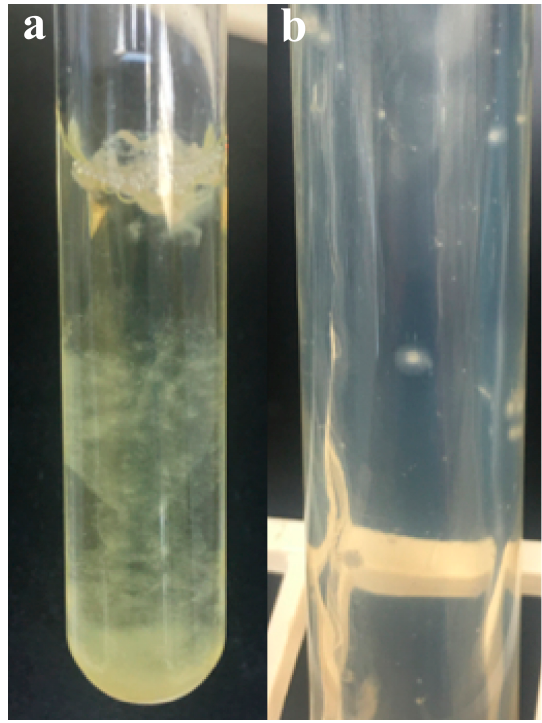
Figure 1. Macroscopic features of Aestipascuomyces dupliciliberans type strain R4. ( a ) Heavy fungal biofilm-like growth in liquid medium and ( b ) circular, white filamentous colonies with a white center of sporangia on cellobiose agar roll